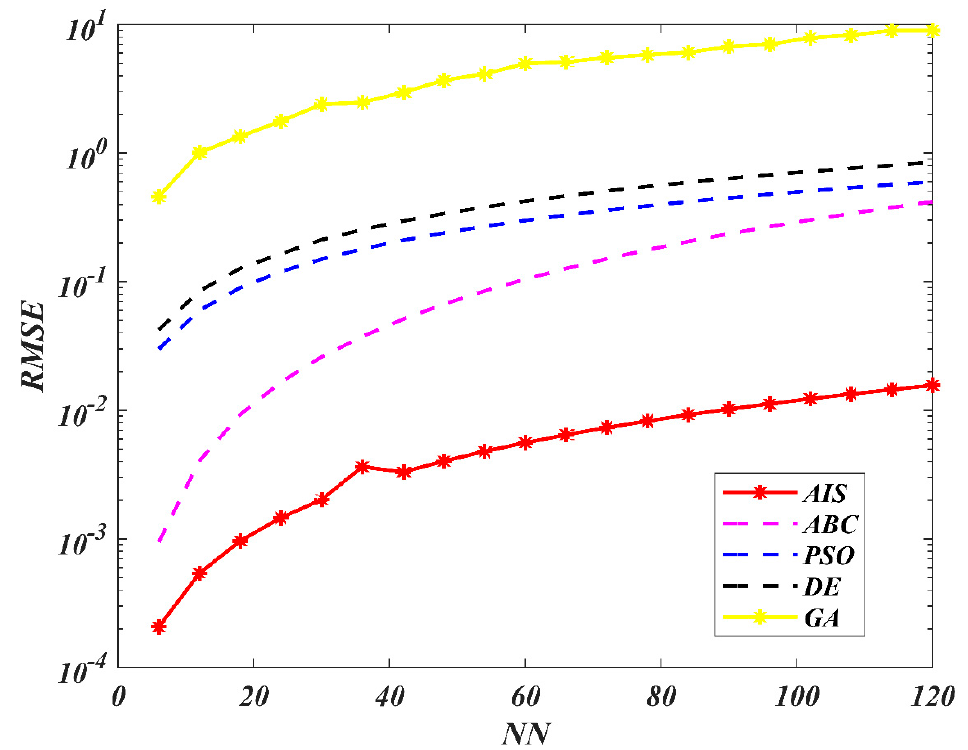
Figure 14. RMSE Evaluation of Hepatitis.